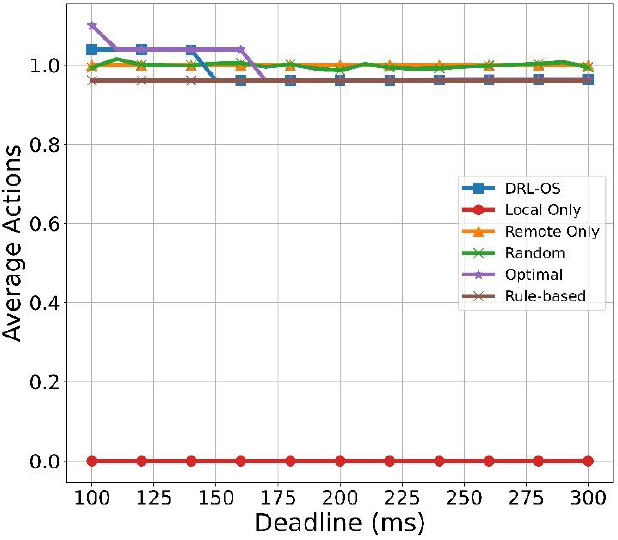
Figure 12. Average action vs. deadline.